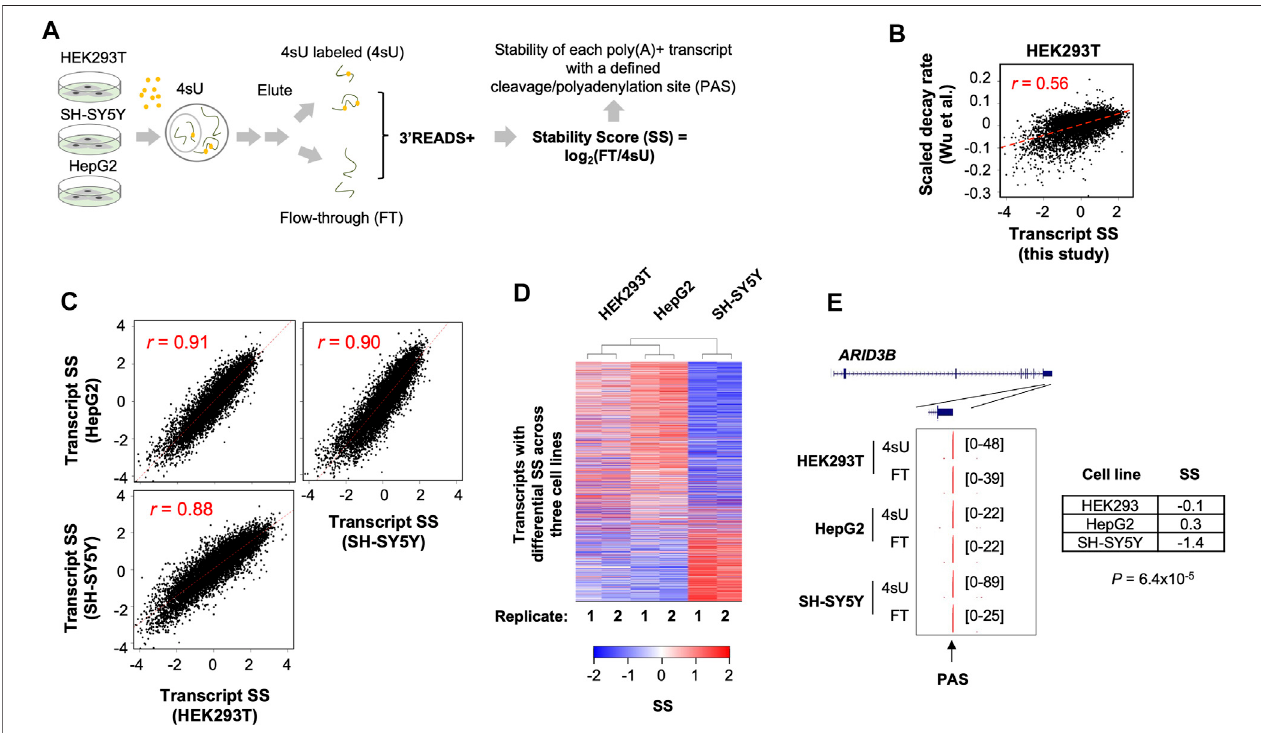
FIGURE 1 | Systemic analysis of poly(A)+ RNA stability in three human cell lines. (A) Schematic of experimental procedure. HEK293T, HepG2, and SH-SY5Y cells were subject to metabolic labeling with 4-thiouridine (4sU) for 1 h. Total cellular RNA was extracted from each sample and was fractionated into 4sU-labeled (4sU) and unlabeled ( fl ow-through or FT) fractions. Isolated RNA was subject to 3 ′ READS+ for 3 ′ end sequencing. Stability Score (SS) of each transcript (represented by its polyA site, or PAS) was calculated by log 2 (FT/4sU), where FT and 4sU are transcript abundances in the FT and 4sU fractions, respectively. (B) Comparison of SS of transcripts in HEK293T cells (this study) with scaled decay rates from a previous study by Wu et al. (GSE126520, NCBI GEO). Pearson correlation coef fi cient r is indicated. (C) Pair-wise comparisons of mRNA SS between 3 cell lines. Pearson correlation coef fi cient r is indicated. Each dot is a gene. When a gene has multiple PAS isoforms, the one with the highest expression value based on the average of all 3 cell lines is used. (D) Heatmap showing mRNA genes with differential SS among the 3 cell lines. Each row is an mRNA gene. Two-way hierarchical clustering was based on Euclidian distance. Genes with signi fi cant differential stability across the cell lines are those with p < 0.05 (ANOVA test). (E) UCSC tracks showing an example gene ARID3B . SS in each cell line and p -value indicating signi fi cance of difference in SS (ANOVA test) are shown. PAS is indicated by an